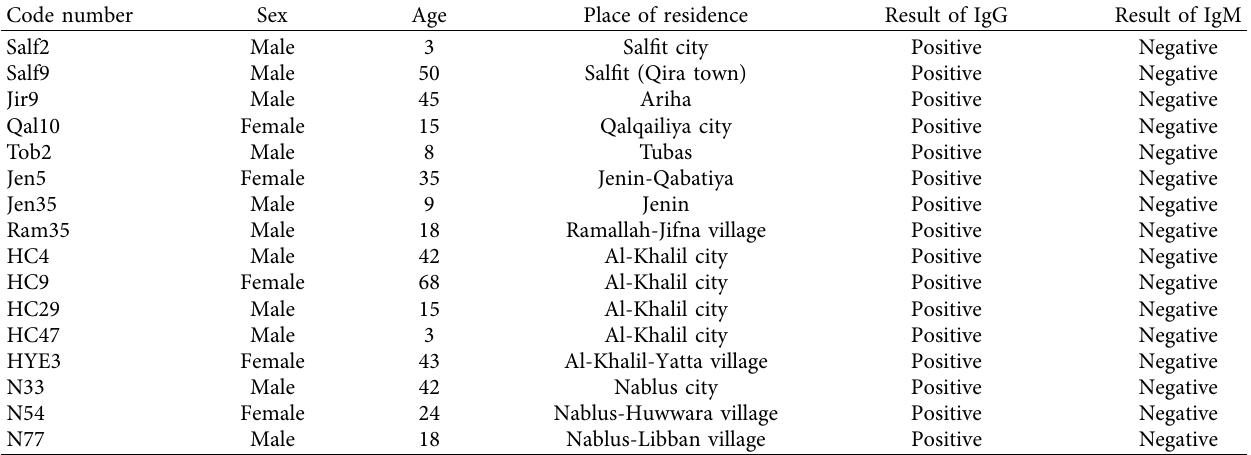
Table 2: Demographic and laboratory test results of the 16 HEV-IgG positive samples.